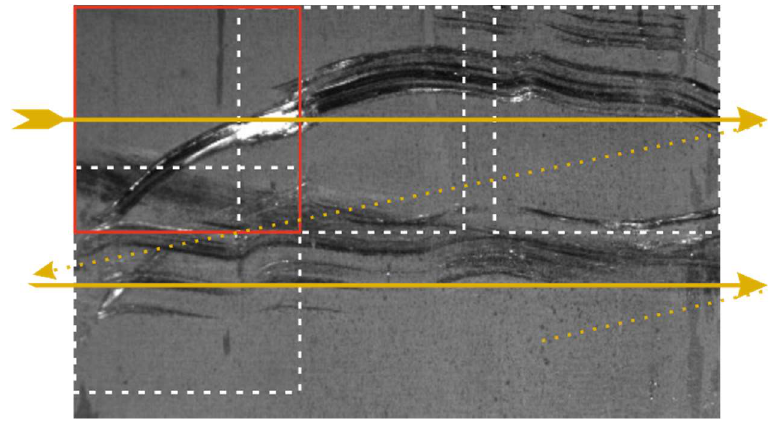
Figure 9. Sliding window for recognizing defects in the image of any size.